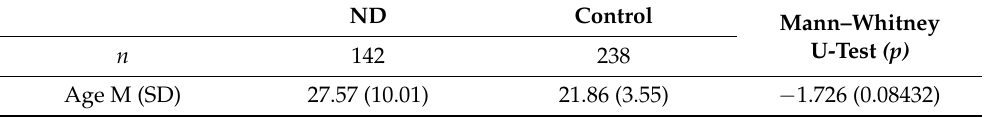
Table 1. The age of participants in the nicotine-dependent (ND) subjects group and control group. ND